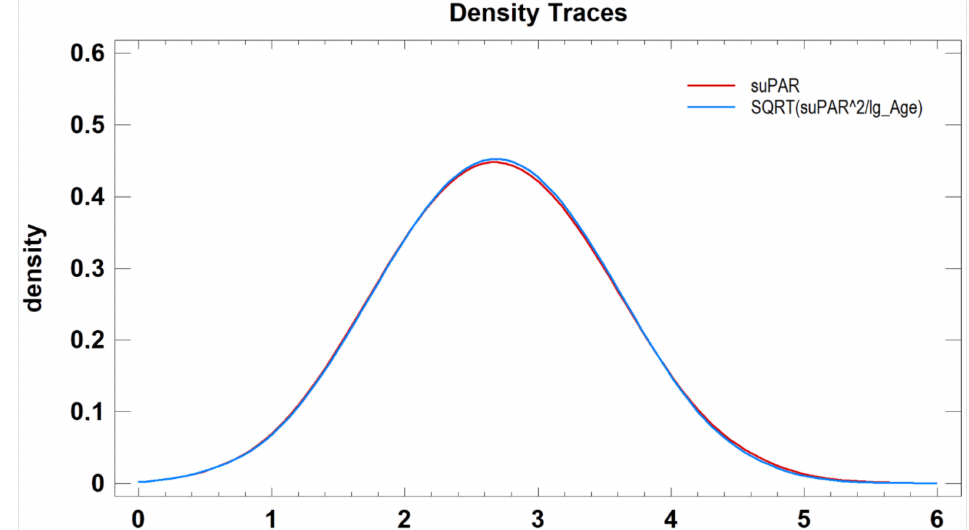
Figure 4. Raw suPAR distributions is the same as the Index of Body Inflammation (calculated as IBI SQRTsuPARˆ2/lg_Age ) distribution ( p = 0.9110; Kolmogorov-Smirnov test 0.5613). In this way a measure of the inflammatory reaction (IBI) is obtained, independent on the patient’s age, with a normal distribution and a range of values similar to the original serum activity test results. Note: The calculation was based on index derived from the Equation